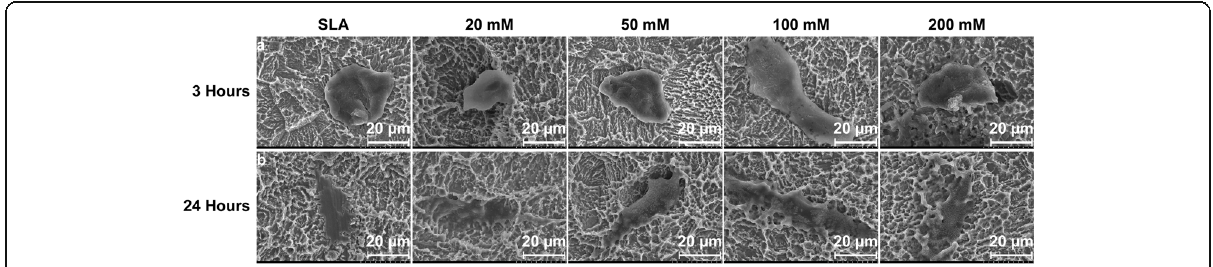
Fig. 6 SEM images of BMSCs cultured on SLA surfaces treated with different concentrations of sodium bicarbonate for 3 h ( a ) and 24 h ( b